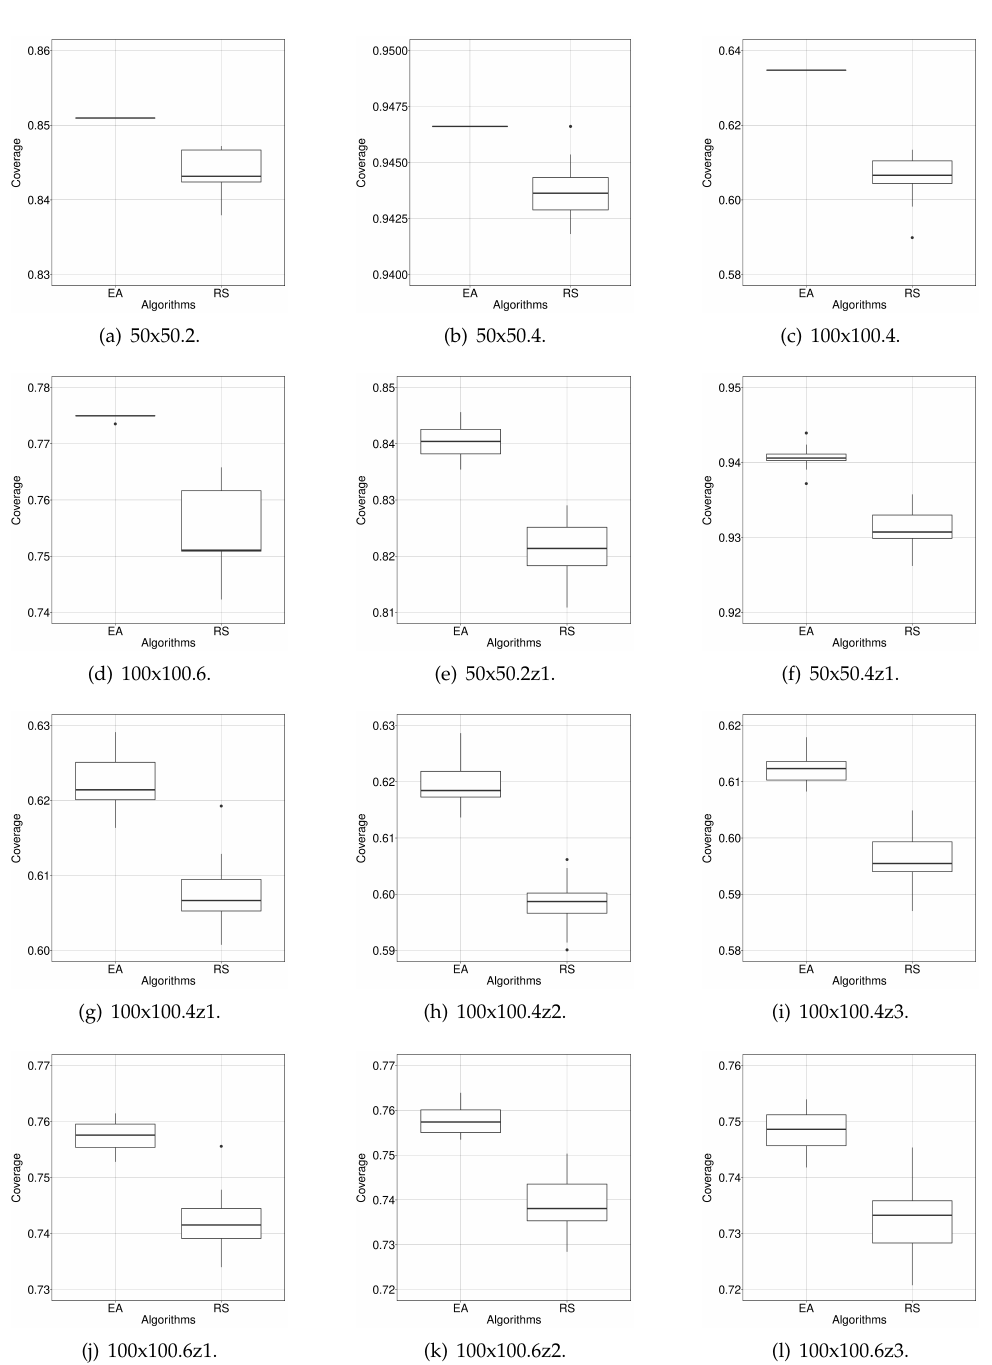
Figure 8. Box plots showing the distribution of values (30 runs) of EA and RS after optimising the proposed 12 case studies. As we are maximising area coverage, the higher the